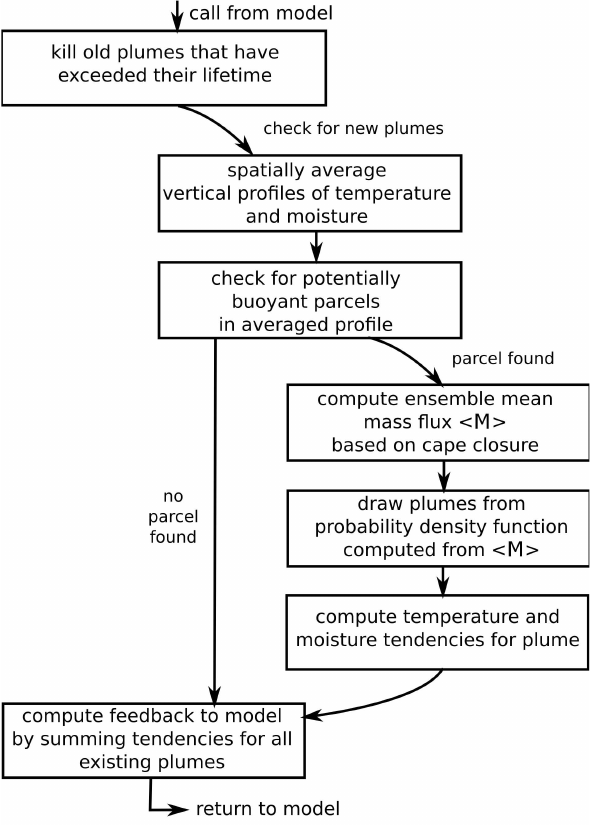
Fig. 1. Flowchart displaying the tasks performed in the Plant-Craig convection